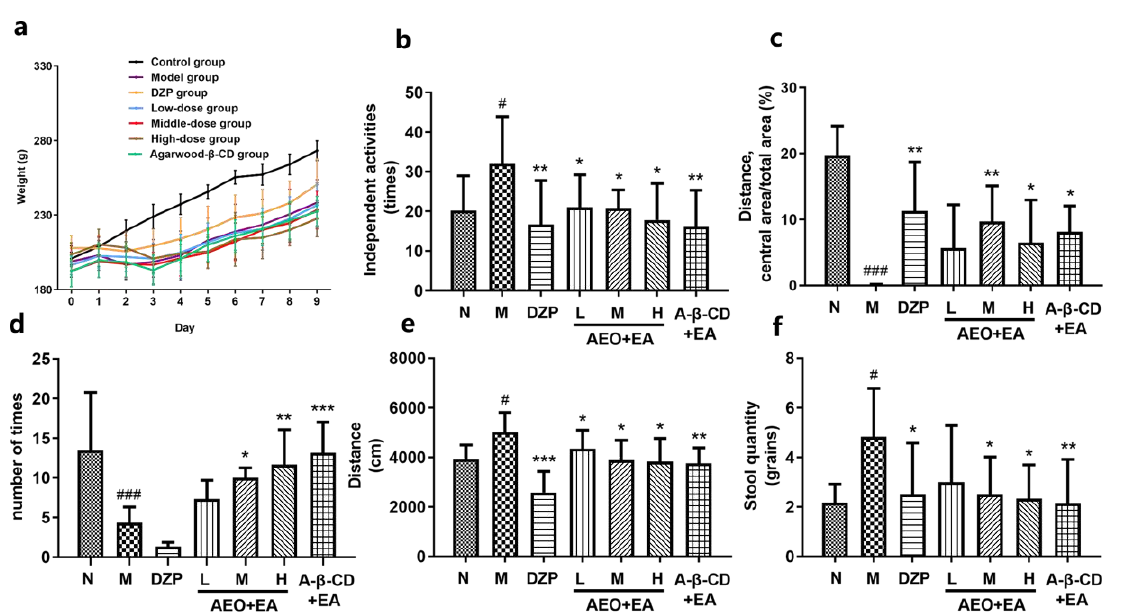
Figure 7. Effects of drugs on the weight change, number of independent activities, and open field test of insomnia animals. ( a ) The weight change, ( b ) the number of independent activities, ( c ) the ratio of the distance between entering the central area and the total area, ( d ) the times of entering the central region, ( e ) the total distance, and ( f ) the number of feces. The low-, middle- and high-dose groups were given the mixture of AEO and EA. The a- β -CD group was given the mixture of a- β -CD and EA. Abbreviations: N—the normal group, M—the model group, DZP—the diazepam group, L—the low-dose group, M—the middle-dose group, H—the high-dose group, and a- β -CD + EA was the a- β -CD group. # p < 0.05 and ### p < 0.001, compared to the normal group; * p < 0.05, ** p < 0.01 and *** p < 0.001 compared to the model group. Data were presented as mean ± SD ( n = 6).